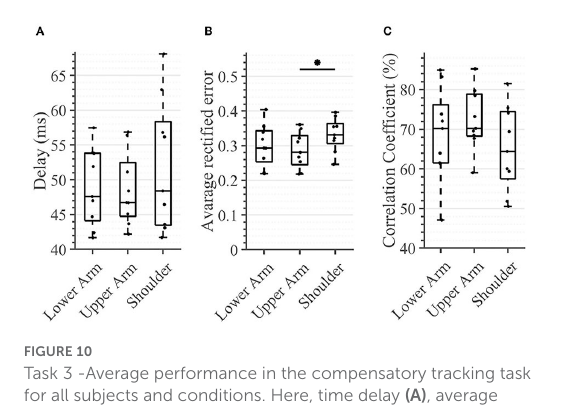
FIGURE8 Task 2 -Weber Fraction. A closer look. in percent, for (A) the distal and proximal parts of the three segments of the arm, (B) the ventral and dorsal parts of the three segments of the arm. The box plots depict the median value (horizontal line) and the IQR (rectangle) of mean ST data collected from 10 subjects. Red crosses indicate statistical outliers within a single box plot ( n = 10).